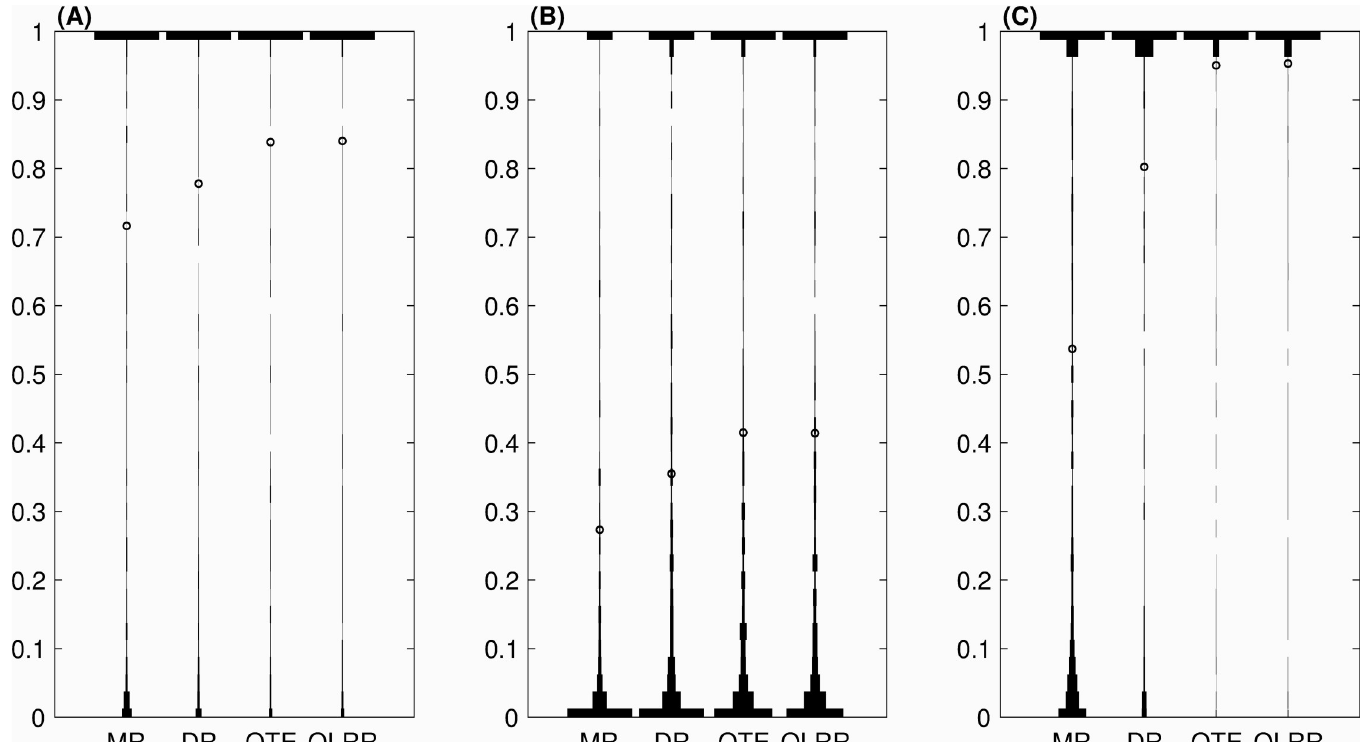
Fig 3. PPLD distributions (violin plots) for (a) Model 2, (b) Model 3 and (c) Model 7, using the indicated form of residual (MR, DR, OTE, OLRR) as input data. The mean of each distribution is marked with an ‘o’.